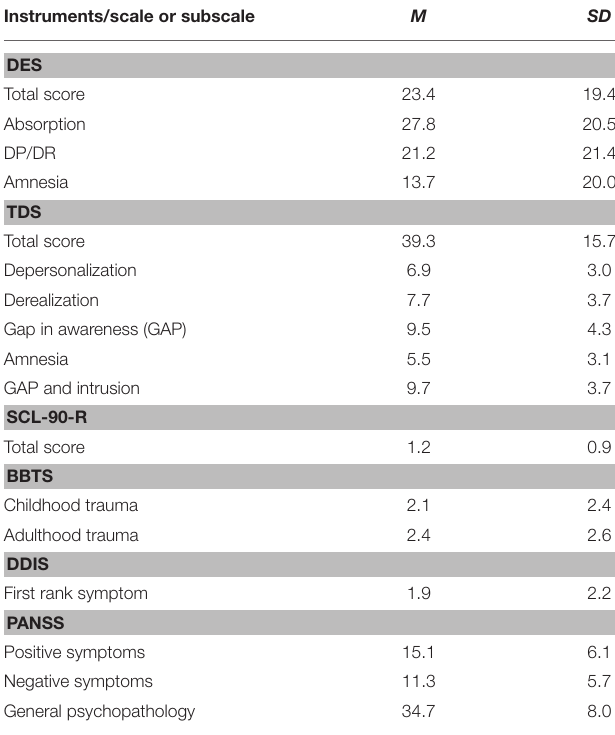
TABLE 1 | The means and standard deviations of the measures of psychopathology and trauma history. Instruments/scale or